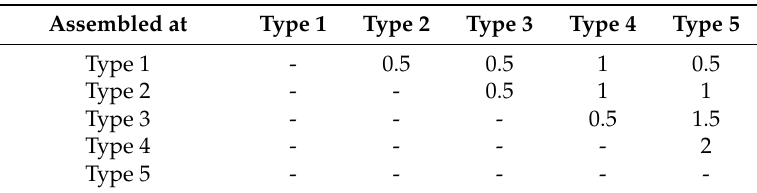
Table 2. Example of the different levels of machine solicitation related to the type of assembly for the proposed